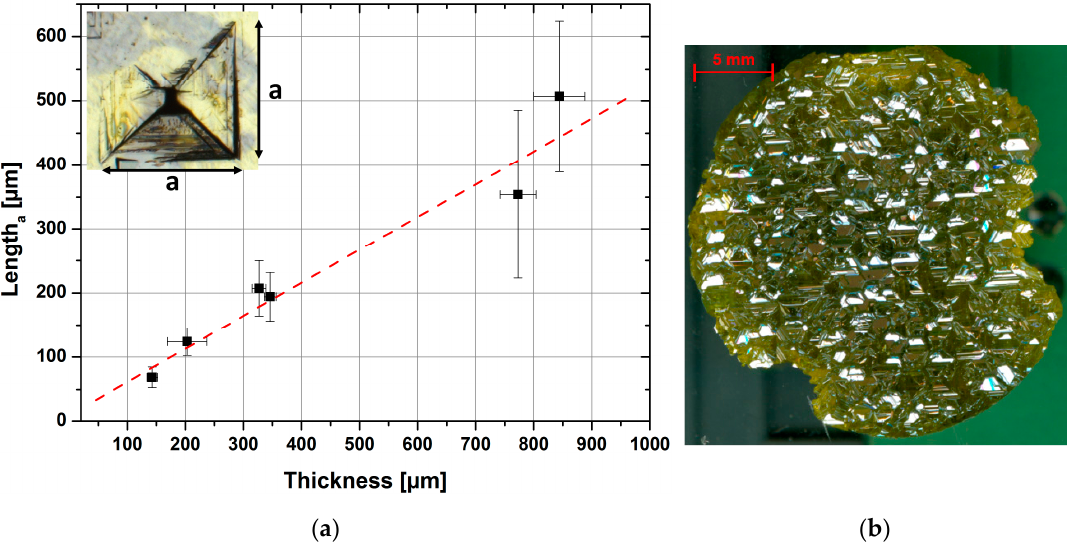
Figure 4. ( a ) Protrusion dimension, measured on the base as a function of crystal thickness. The inset presents a top-down view of a protrusion defect, showing an inverse pyramid. The length a describes the base of such a pyramid created by stacking faults penetrating the surface. ( b ) Surface image of an approximately 2.7 mm thick one-inch sample dominated by the protrusion defect.